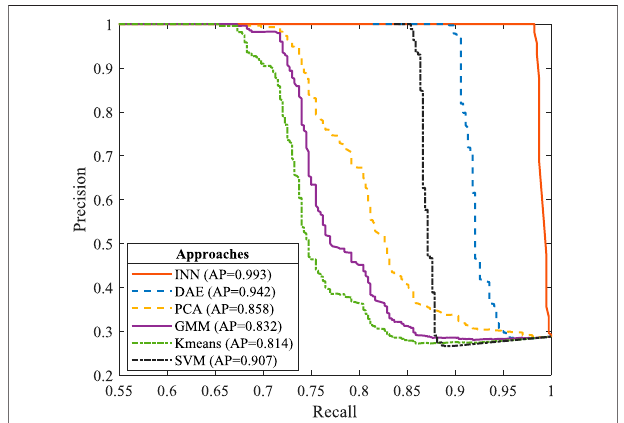
FIGURE 11 | PRCs of different approaches with simulated data in the IEEE 34-bus system. APs of INN are larger than others, which veri fi es the advantages of INN.